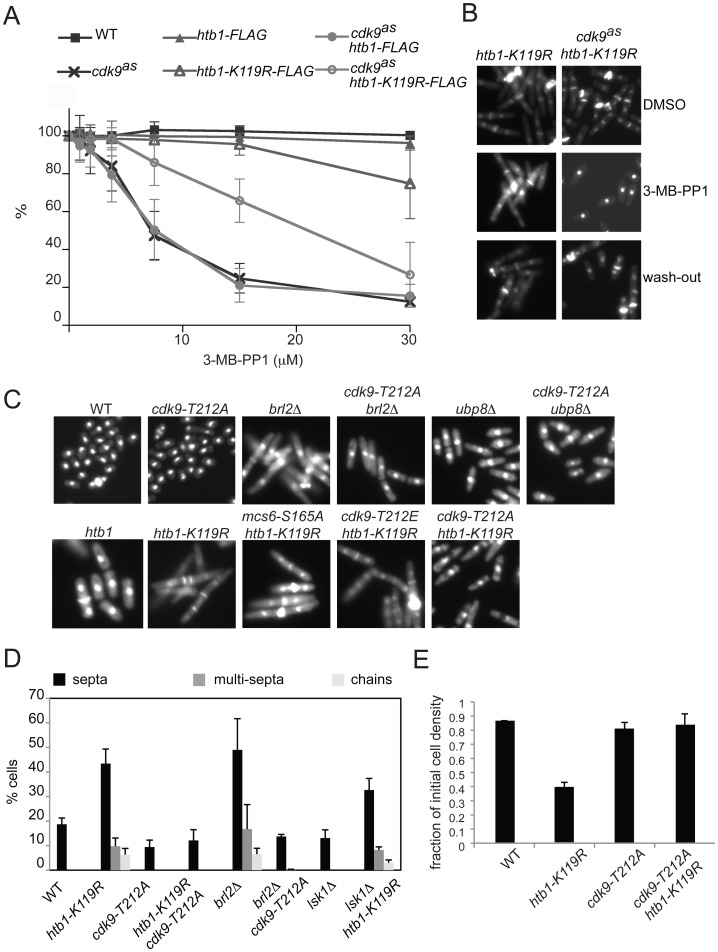
Mutual phenotypic suppression in cdk9 htb1-K119R double mutants.(A) For indicated strains (JS78, LV7, JTB62-1, JTB67-1, MS249, LV193), growth in increasing [3-MB-PP1] is plotted as a percentage of growth in the absence of 3-MB-PP1. Error bars denote standard deviations from 3 independent experiments. (B) Images of DAPI- and calcofluor-stained htb1-K119R (JTB67-1) and cdk9as htb1-K119R (LV193) cells grown in the absence (top) or presence (middle) of 10 µM 3-MB-PP1 for 7 hr, or after inhibitor washout and return to growth (bottom). (C) Fluorescent images of DAPI/calcofluor-stained wild-type (JS78), cdk9-T212A (HD7-24), brl2Δ (JTB331), brl2Δ cdk9-T212A (JTB335), ubp8Δ (JTB297), ubp8Δ cdk9-T212A (JTB336), htb1-K119R (JTB67-1), cdk9-T212A htb1-K119R (LV252) cdk9-T212E htb1-K119R (LV256), and mcs6-S165A htb1-K119R (LV254) cells. (D) Quantification of abnormal septation patterns in strains of indicated genotypes (JTB62-1, JTB67-1, JTB325, JTB326, JTB331, JTB335, JTB377, JTB333 respectively). Error bars represent standard deviations from 2 independent experiments; at least 200 cells were counted in each. (E) Flocculation of indicated htb1-FLAG strains (JTB62-1, JTB67-1, JTB325, JTB326) was quantified as described in Materials and Methods. Error bars denote standard deviations from 2 independent experiments.